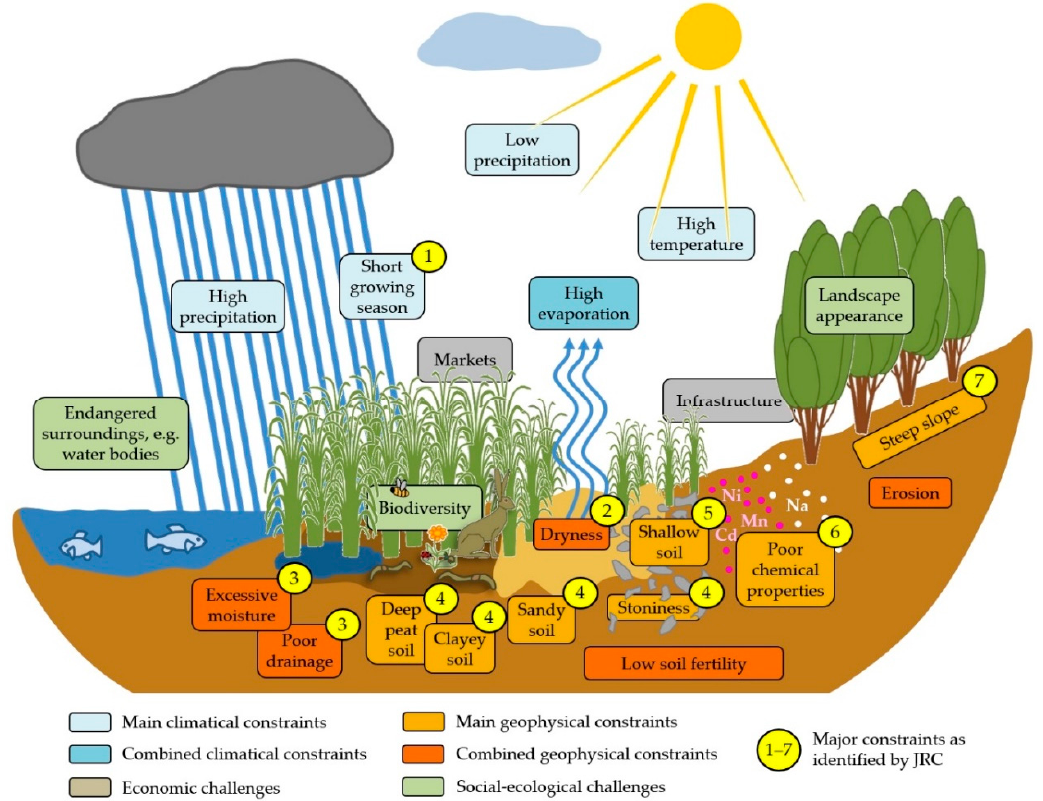
Figure 2. Illustration of relevant biophysical constraints and both economic and social-ecological challenges selected for marginal agricultural land low-input systems (Source: This study). Numbers 1–7 indicate the major biophysical constraints on marginal lands as defined by the Joint Research Centre (JRC) [20–22]. The other parameters either influence (main constraints) or follow on (combined constraints) from the major biophysical constraints, which limit the site-specific plant growth suitability (Table A1). The economic and social-ecological challenges have been added, due to their increasing relevance for modern agricultural systems [23–26]. These challenges can render a site marginal under both economic and social-ecological aspects, such as environmental protection, biodiversity conservation, infrastructure, markets and landscape appearance.